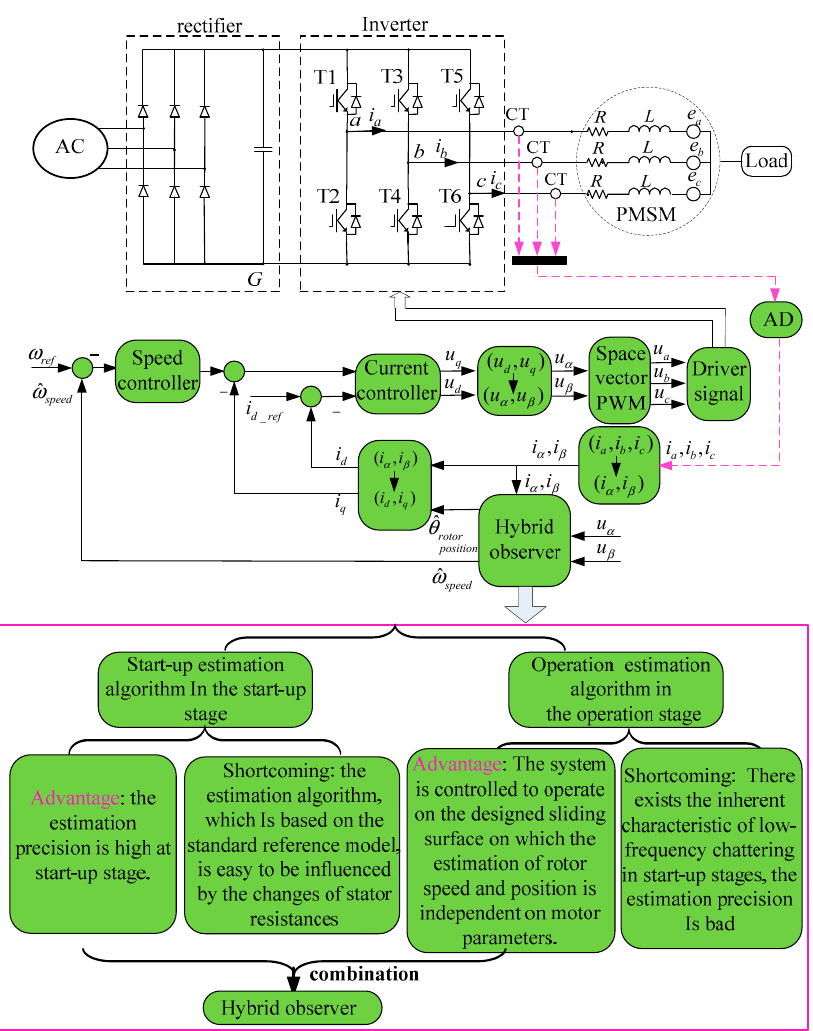
Figure 3. Sensorless double closed-loop control and the design scheme of hybrid observer.